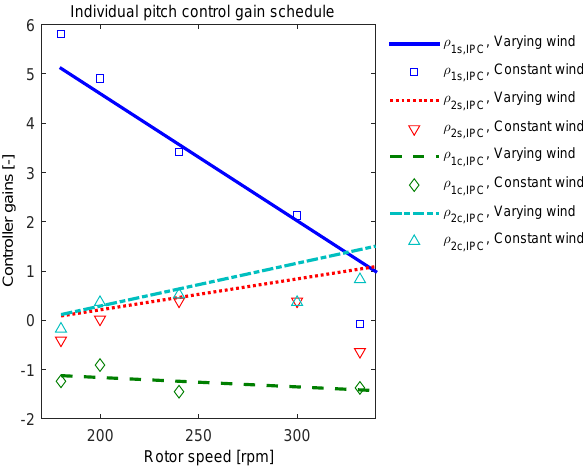
Figure 22. Optimisation of gain schedule intercepts for varying wind speed conditions.